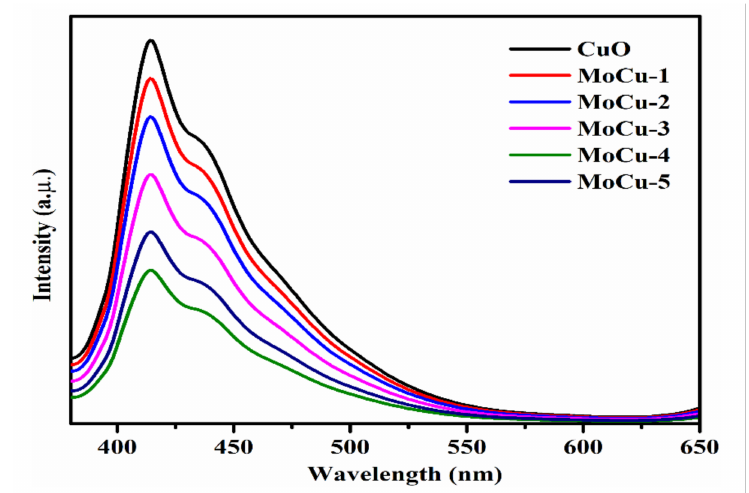
Figure 6. PL spectra for pure CuO, MoCu-1, MoCu-2, MoCu-3, MoCu-4, and MoCu-5 samples.